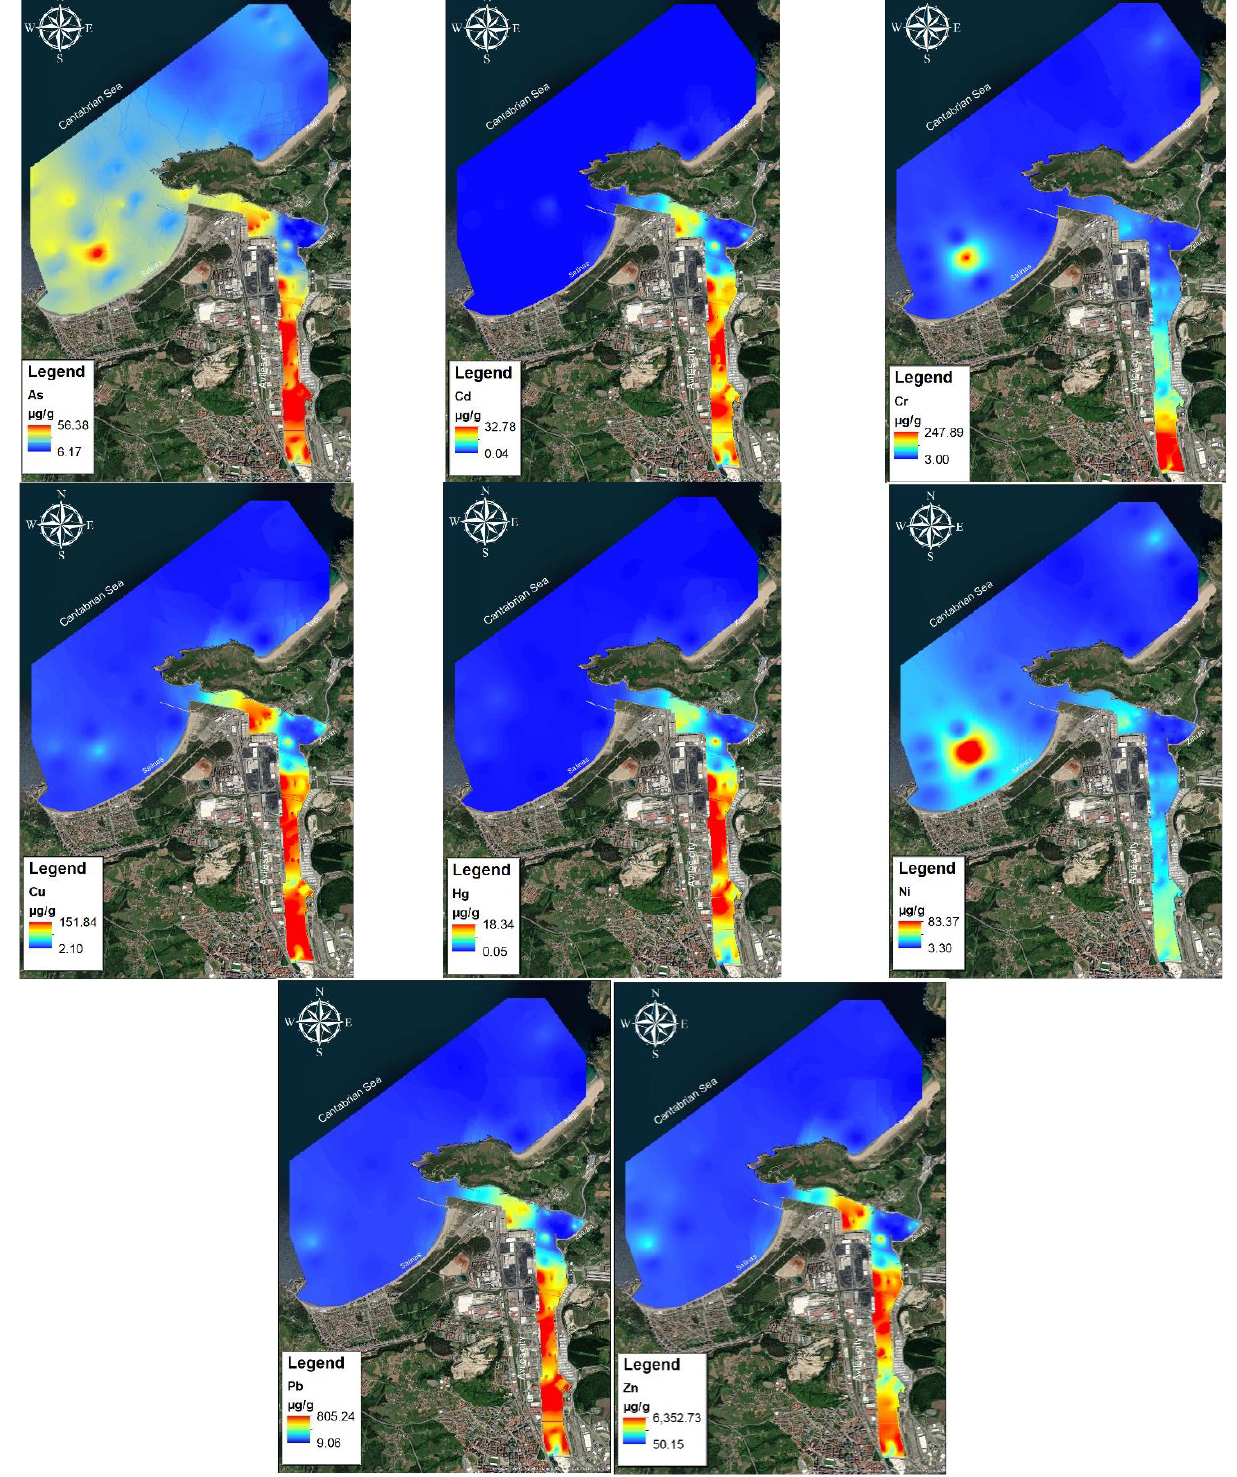
Figure 3. Spatial distributions of the concentrations of As, Cd, Cr, Cu, Hg, Ni, Pb and Zn in surface sediments of the Aviles estuary and the nearby coastal area. sediments of the Aviles estuary and the nearby coastal